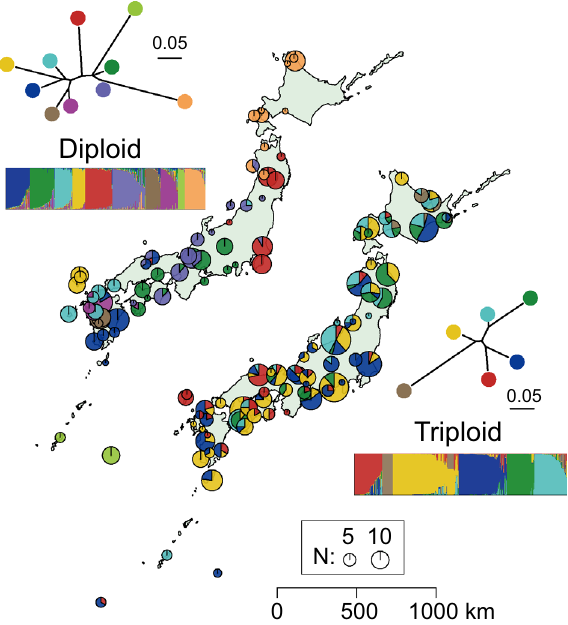
Figure 5. STRU CTU RE results for diploid ( K = 10, left) and triploid ( K = 6, right) Carassius based on microsatellites. Relative sample sizes of clusters are shown as a pie chart on the map. NJ trees indicate allele frequency divergence between genetic groups inferred by STRU CTU RE, and the tips are colored corresponding to the colors of clusters. In most of the river systems, triploid individuals are identified in multiple clusters. The maps were generated using the R package